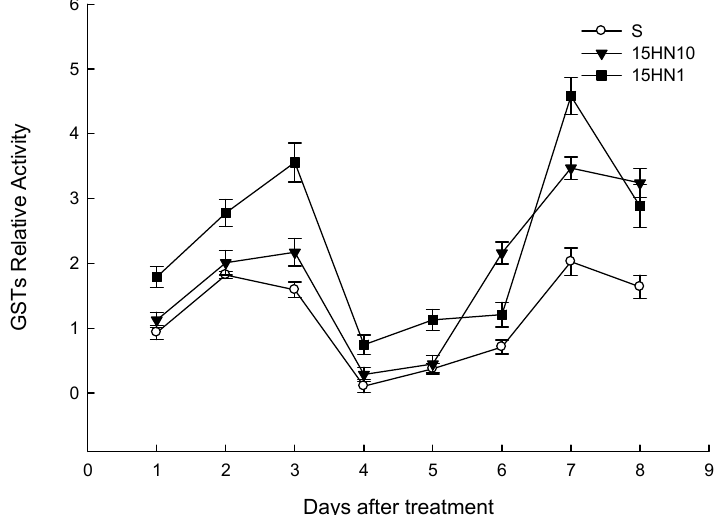
Figure 2. Relative activities of glutathione S-transferase in resistant (15HN10, 15HN1) and susceptible (S) Digitaria sanguinalis populations.